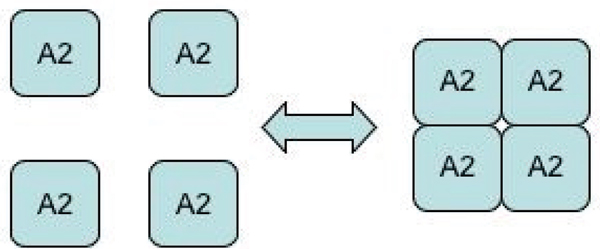
hnRNP A2 forms oligomers. Individual hnRNP A2 molecules form homotypic interactions with other hnRNP A2 molecules to generate oligomers.